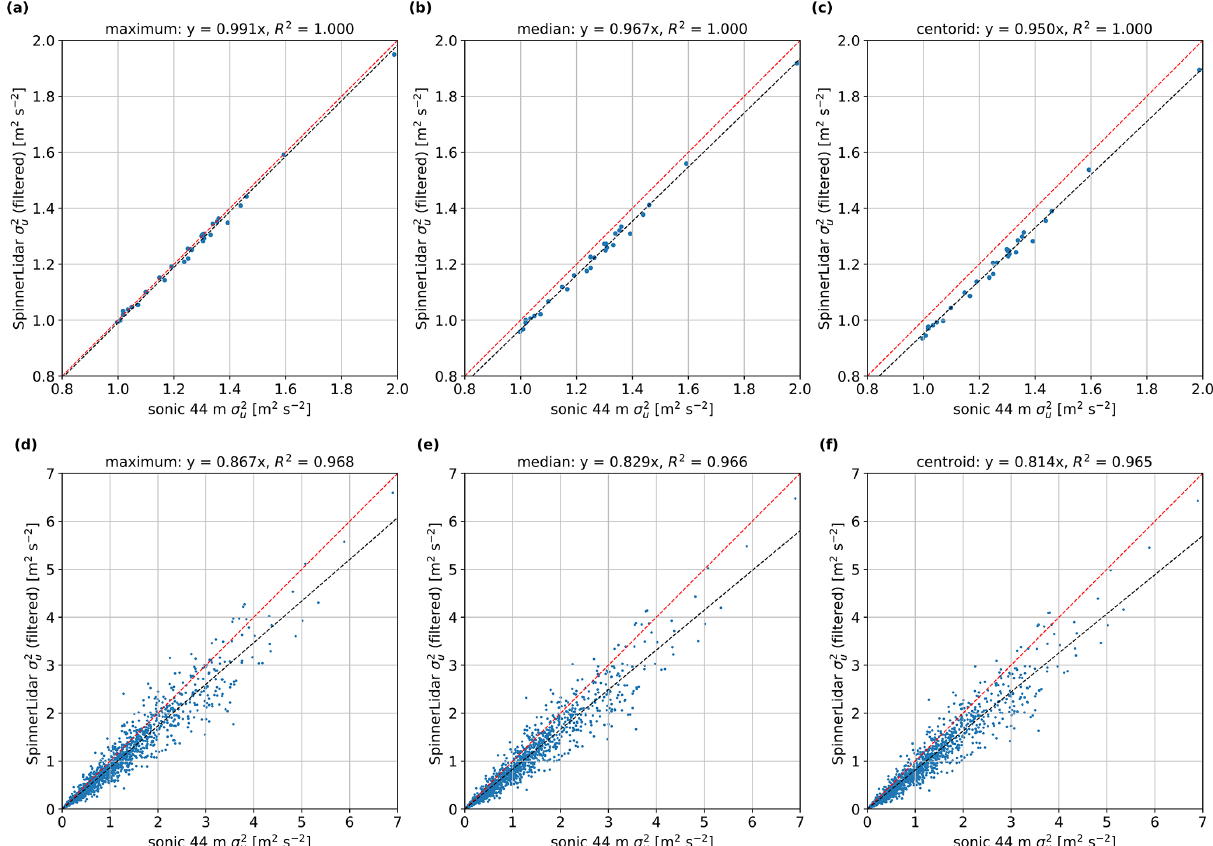
Figure 15. Comparison of the filtered variance of the along-wind velocity component between the SpinnerLidar and the sonic anemometer at 44m. (a–c) Numerical simulations using 30 turbulence boxes. (d–f) Measurement campaign.